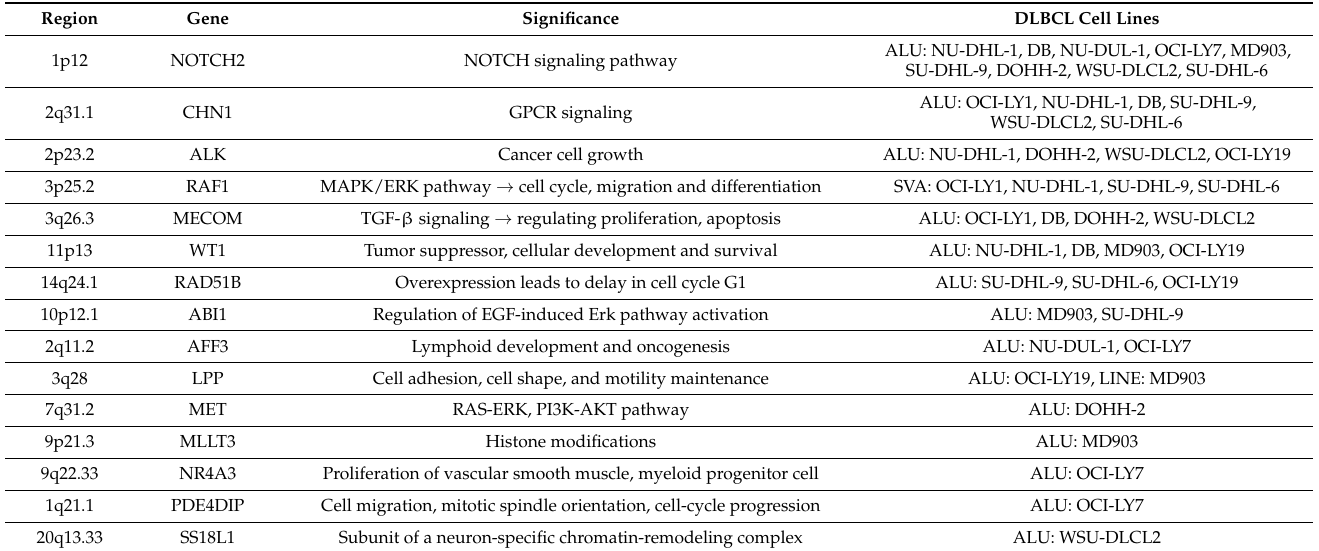
Table 2. List of key genes altered as a result of MEIs in 11 DLBCL cell